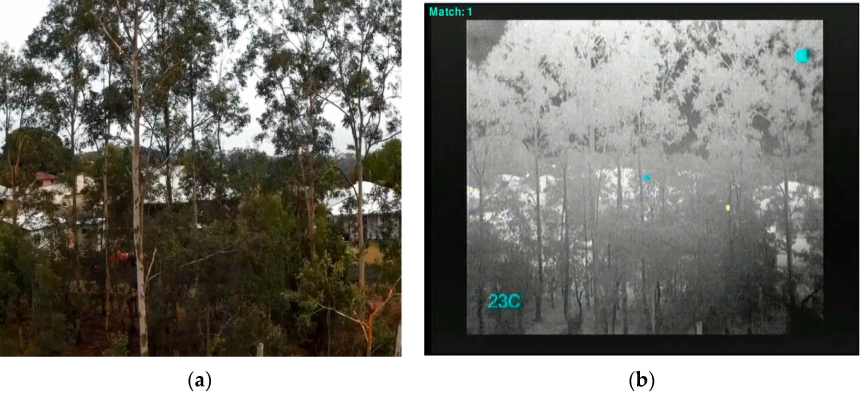
Figure 19. ( a ) Digital image ( b ) koala tracking and detection above the canopy with image of canopy with side – lateral view detection at 20